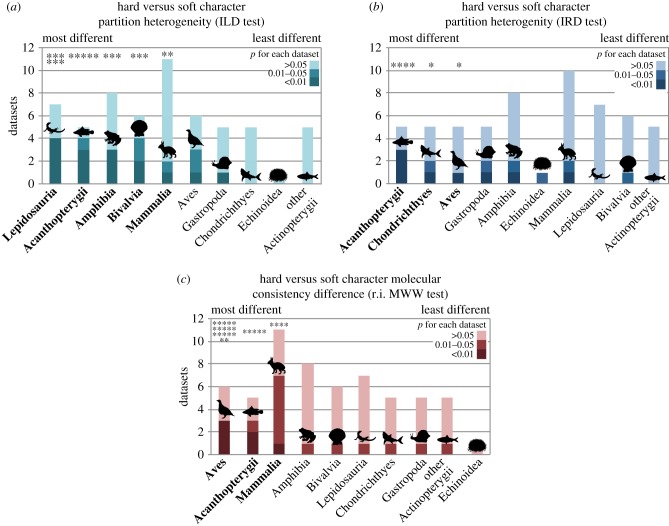
Results of partition tests. Datasets are grouped by class and are colour coded according to their individual p-value for (a) the Incongruence Length Difference (ILD) test, (b) the Incongruence Relationship Difference (IRD) test, and (c) the molecular consistency difference test (i.e. MWW test of retention indices of characters in each partition relative to molecular trees). The grouped classes are arranged from those exhibiting most differences (left) to least differences (right) (Fisher's combined probability test derived from combined p-values of datasets in each clade). Classes with combined significance are in bold and highlighted with asterisks denoting the level of significance. (Online version in colour.)